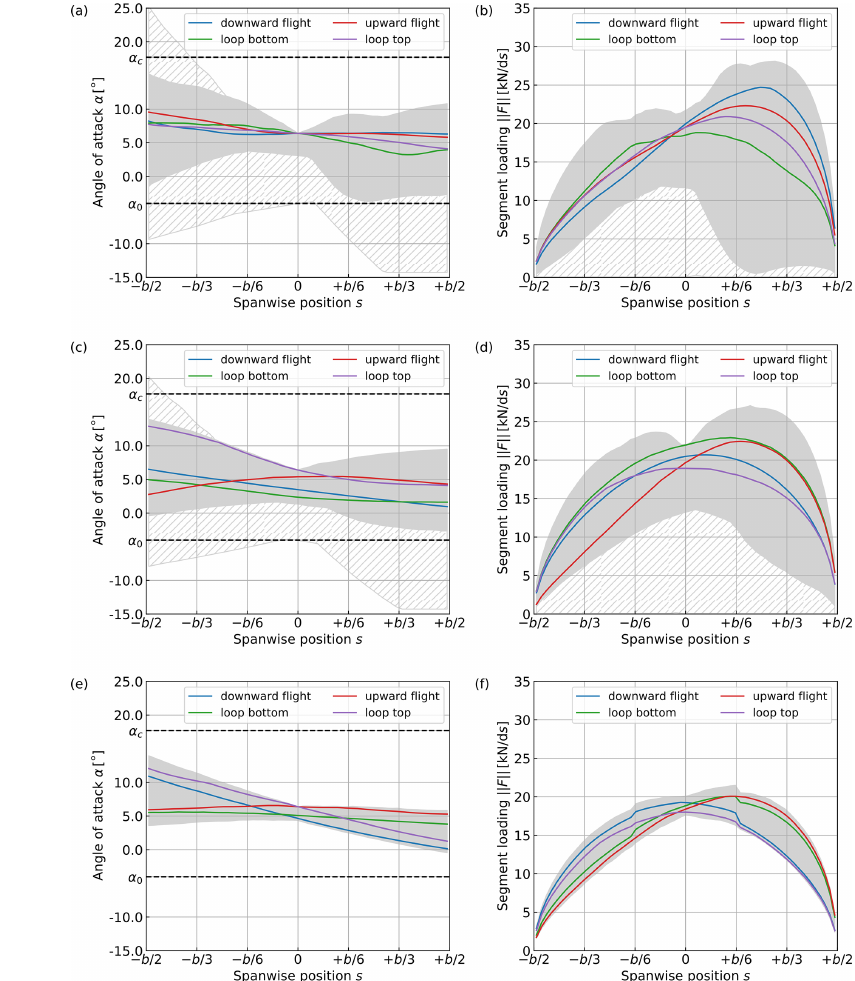
Figure A4. Distributions of angle of attack and wing loading along the wingspan of (a, b) the lift-mode AWE system with original bounds, (c, d) the lift-mode AWE system with induction-based limitation of reel-out speed, and (e, f) the drag-mode AWE system. The coloured lines show the distributions at selected stages of the trajectories. The grey shaded areas show the value range during power generation while the hashed areas only show the reel-in phase.